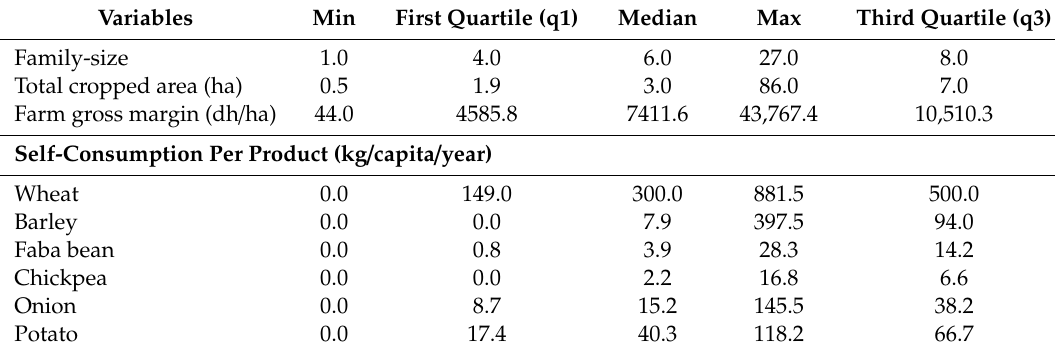
Figure 2. Frequency distribution of farms by size of land holding. Table 2. Descriptive statistics on demography, land use, gross margins and self-consumption for sample